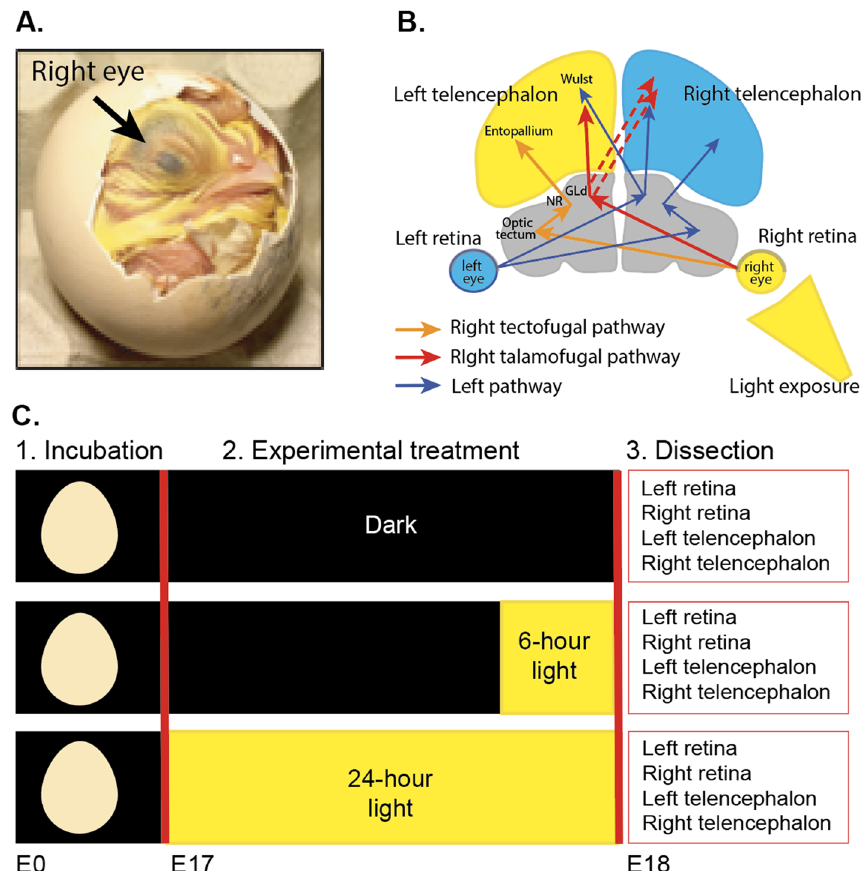
Figure 1. ( A ) Asymmetric position of chick embryos. By embryonic day 17 (E17), the right eye is located toward the shell and the left eye tucked under the wing. Only right eye is directly exposed to light. ( B ) Representation of the visual system in chicks. The two arrows that depart from the retina indicate the tectofugal and thalamofugal pathways (see 55 ). The left tectofugal pathway (orange pathway via right retina, left optic tectum, left nucleus rotundus (NR) and left entopallium in the left telencephalon) and left thalamofugal pathway (red pathway via right retina, left thalamic nucleus geniculatus lateralis pars dorsalis (GLd), left Wulst in the left telencephalon and right Wulst in the right telencephalon) are shown. The right tectofugal and thalamofugal pathways (fed by the left retina) are represented in blue. The regions used in the RNA-seq analysis (retina and telencephalon) are coloured. ( C ) Schematic representation of the experimental phases. Eggs were incubated in the dark from embryonic day 0 (E0) to embryonic day 17 (E17). On day E17, eggs were randomly assigned to one of three different experimental treatments. One group continued incubation in darkness (Dark), one group was exposed to 6 h of light (6-h light) and one group was exposed to 24 h of light (24-h light). At the end of the experimental treatment (E18), dissections were conducted. After dissection, sex was determined by PCR. RNA- seq analysis was carried out on samples from 5 males per light